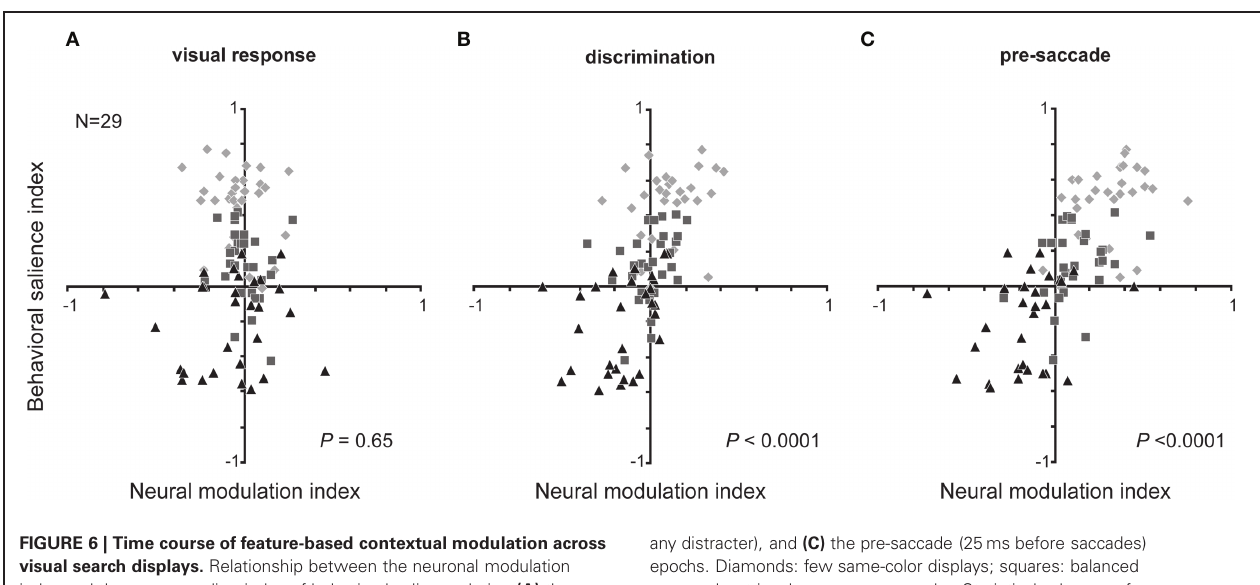
FIGURE 6 | Time course of feature-based contextual modulation across visual search displays. Relationship between the neuronal modulation index and the corresponding index of behavioral salience during (A) the visual response (25ms from visual response latency), (B) the discrimination (25ms centered on the time neurons discriminated target from